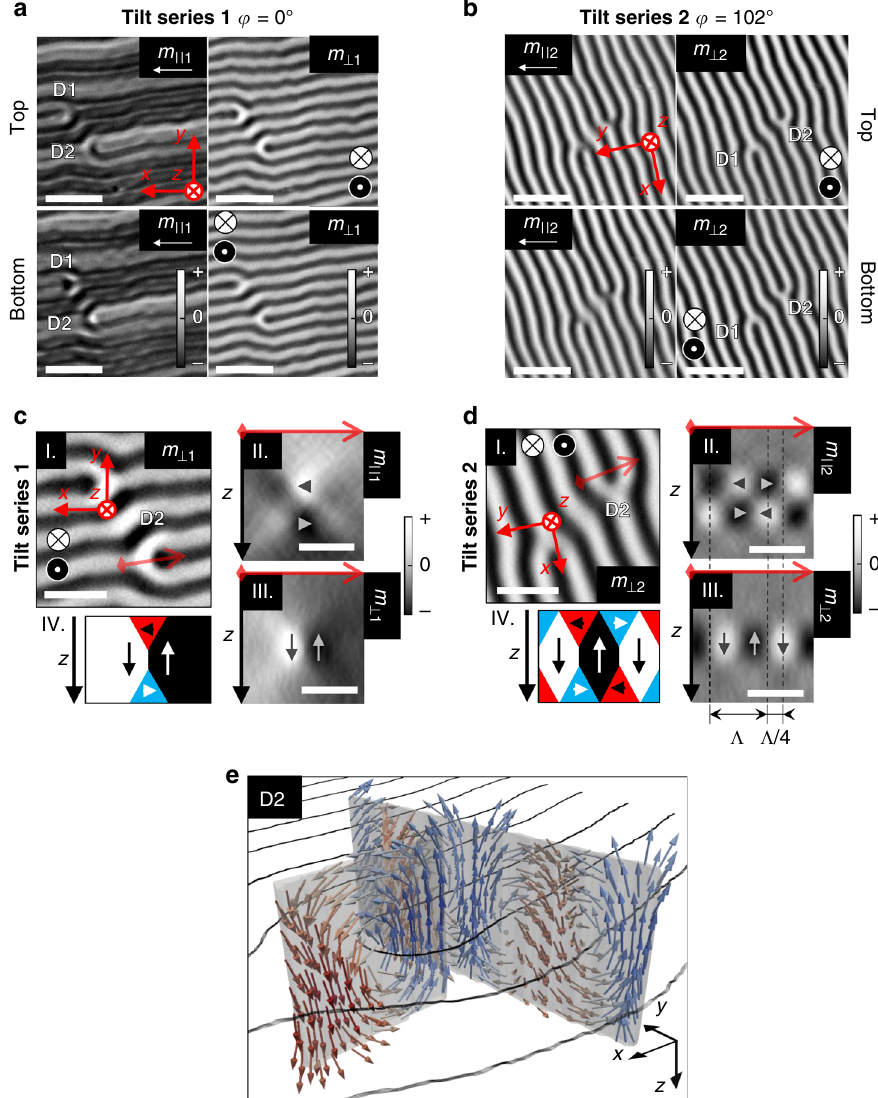
Fig. 2 Tomographic reconstruction of 3D magnetization con fi guration in the striped domain pattern. a , b Reconstructed magnetization at the central slices of top and bottom Py layers showing in-plane ( m || ) and out-of-plane ( m ⊥ ) components from Tilt series 1( a , φ = 0°) and 2 ( b , φ = 102°). Scale bars 1.4 µ m. D1 and D2 index the bifurcations in the image. c , d Analysis of the reconstructed magnetization around dislocation D1 for Tilt series 1 ( c ) and 2 ( d ): (I) Top view of m ⊥ at central slice of volume model. Red arrows indicate the extracted cross-sections. Cross-sections show in-plane (II, m || ) and out-of- plane (III, m ⊥ ) components of the reconstructed magnetization for Tilt series 1 ( c ) and 2 ( d ). (IV) Sketches showing the closure magnetization structure in the selected cross-sections for Tilt series 1 ( c ) and 2 ( d ). Scale bars 700 nm (top view) and 350 nm (cross-section). Gray scale bars indicate the sign of the magnetization. Vertical dashed lines in d indicate the striped domain pattern periodicity ( Λ ) and the Λ /4 dephasing in between m ||2 and m ⊥ 2 components in the closure domain structure. e 3D vector representation of the reconstructed magnetization from the selected cross-sections. Black lines indicate the Bloch